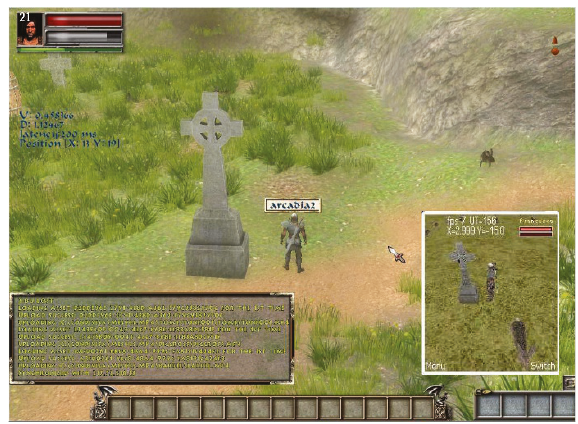
Figure 1: Screen shots from both the PC and CP versions of GOAL, OLGA’s